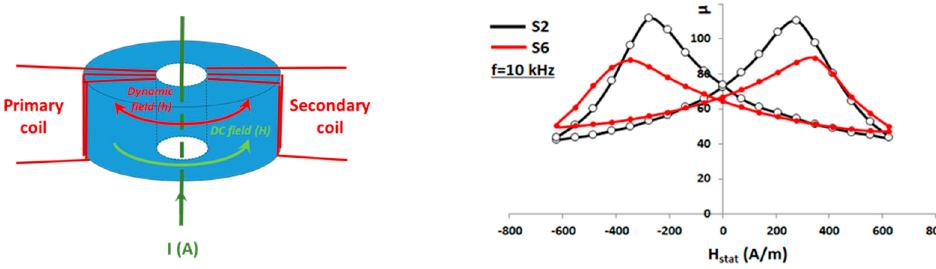
Figure 6. The transformer method and the permeability dynamics of samples S2 and S6 measured at frequency f = 10 kHz.